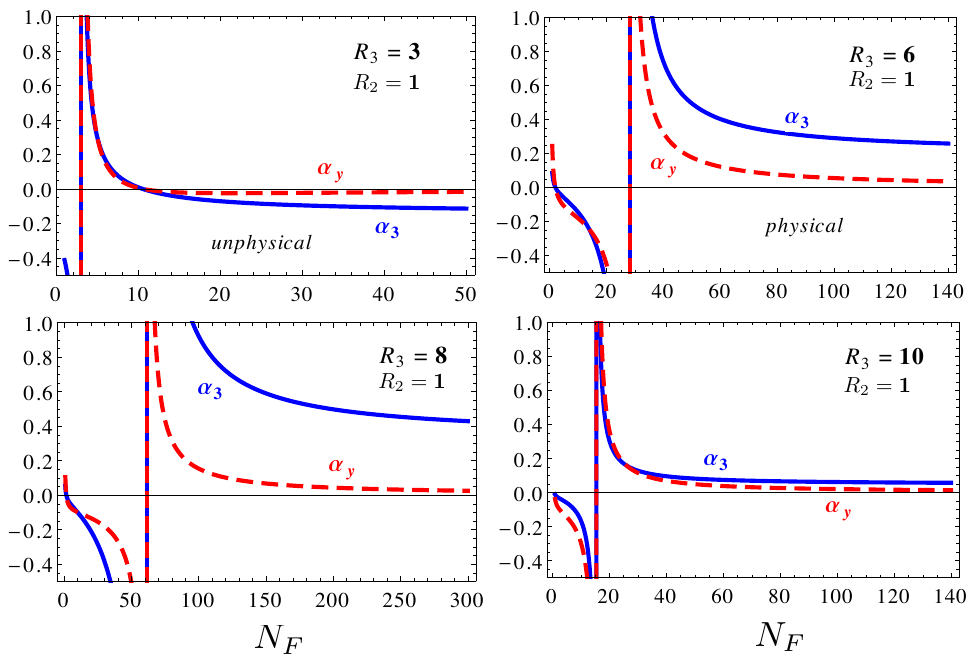
Figure 1 . Partially interacting (cid:12)xed point FP 3 with (cid:11) (cid:3) solid line) and the BSM Yukawa coupling (cid:11) (cid:3) (cid:13)avors for R 2 = 1 and di(cid:11)erent SU(3) C representations R 3 = 3 ; 6 ; 8 and 10 (see main text). points to be UV (cid:12)xed points is the loss of asymptotic freedom in the gauge sector B AS < 0, meaning